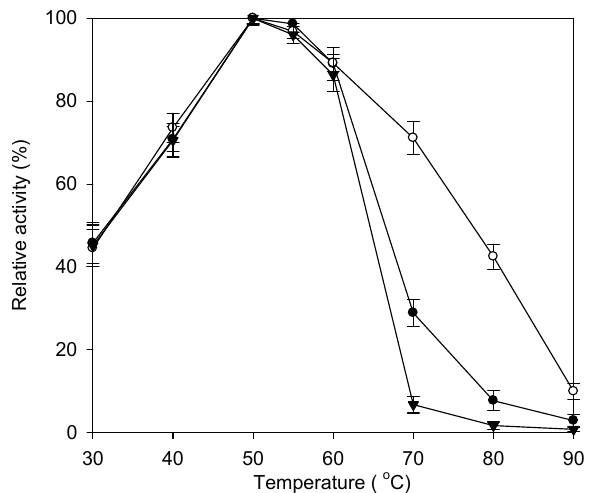
Figure 3. Effect of temperature on the enzyme activity at pH 6.0. Fe 3 O 4 -CS-immobilized enzyme (0.2 g), Fe 3 O 4 -CS-THP-immobilized enzyme (0.2 g) or the free enzyme (1 mL) was added to 100 mL of 5% (w·v − 1 ) lactose at pH 6.0 in a 500 mL Erlenmeyer flask and incubated at various temperatures from 20 to 90 °C in an orbital shaker bath at 200 rpm for 10 min. The relative activity was determined by measuring the production of glucose. The data are averaged from three samples. ( ● ) Fe 3 O 4 -CS-immobilized enzyme; ( ○ ) Fe 3 O 4 -CS-THP-immobilized enzyme; ( ▼ ) free enzyme.